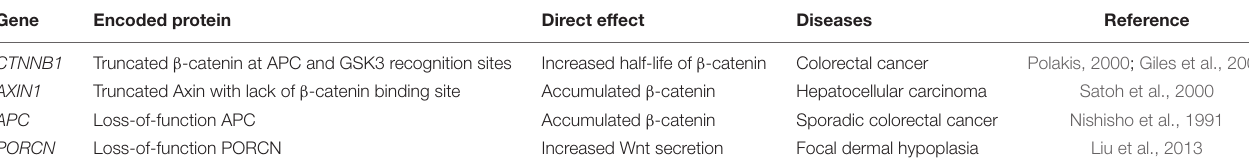
FIGURE 2 | Activated canonical Wnt signaling pathway and the drug targeted components. (1) Signal transduction is activated upon binding of Wnt from outside the cell to Fzd and LRP 5/6 at the cell membrane. (2) Dvl and subsequently Axin, GSK3, CK1 are recruited to the cell membrane and thus inhibiting the formation of multiprotein destructive complex. (3) Accumulated cytoplasmic β -catenin is further translocated into nucleus. (4) Transcription of Wnt targeted genes is activated upon binding of nuclear β -catenin to TCF/LEF. (5) Wnt palmitoylation and secretion to outside of the cell is facilitated by PORCN in the endoplasmic reticulum (ER). (A) OMP54F28 and sFRP4 are antagonists for Wnt and Fzd interaction while DKK1 antagonizes Wnt/ β -catenin signaling through binding to LRP 5/6. (B) LGK974, Wnt-C59, and ETC 159 are inhibitors for PORCN activities. (C) Curcumin acts as an inhibitor for nuclear translocation of cytoplasmic β -catenin. (D) PNU74654 functions as an inhibitor for interaction nuclear β -catenin with TCF/LEF. TABLE 1 | Mutation in genes encoding for components of Wnt signaling